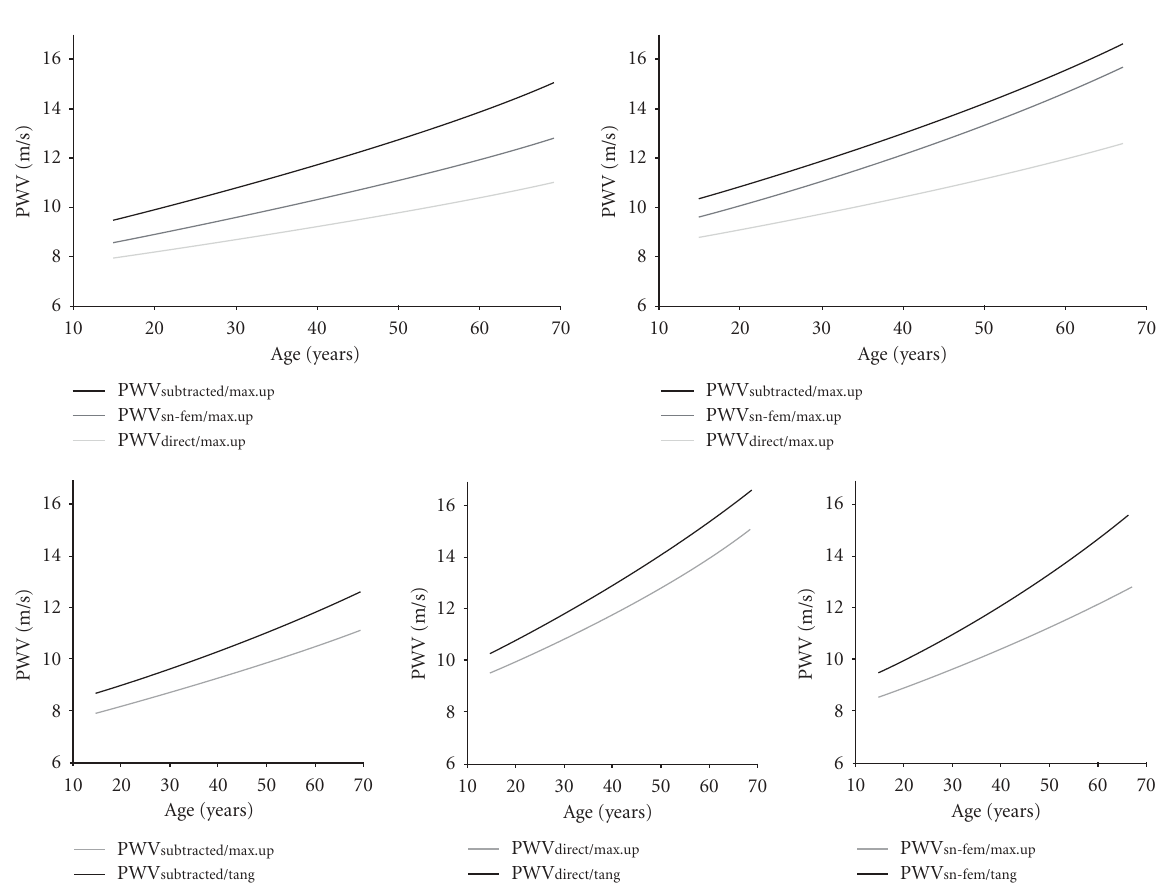
Figure 3: PWV thresholds (percentile 97.5) di ff erences considering di ff erent combinations of distances and algorithms used to calculate